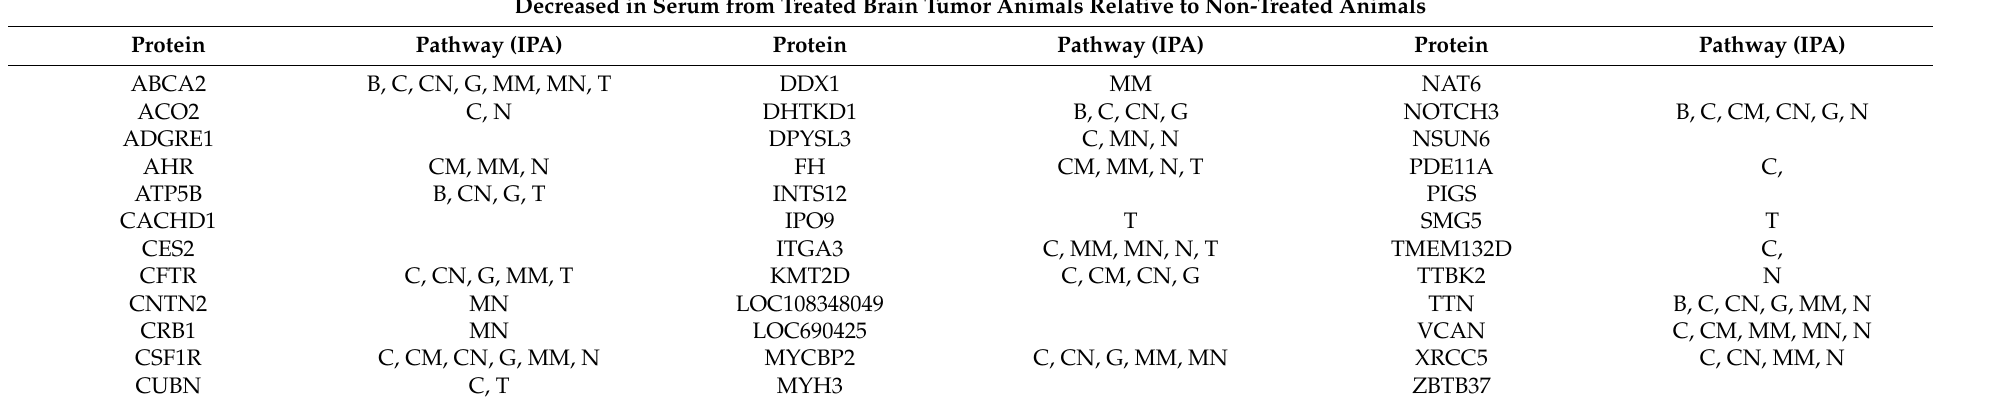
Table 2. Peptides/proteins identified by tandem MS/MS to be elevated or decreased in sera from rat brain tumor drug-treated or untreated